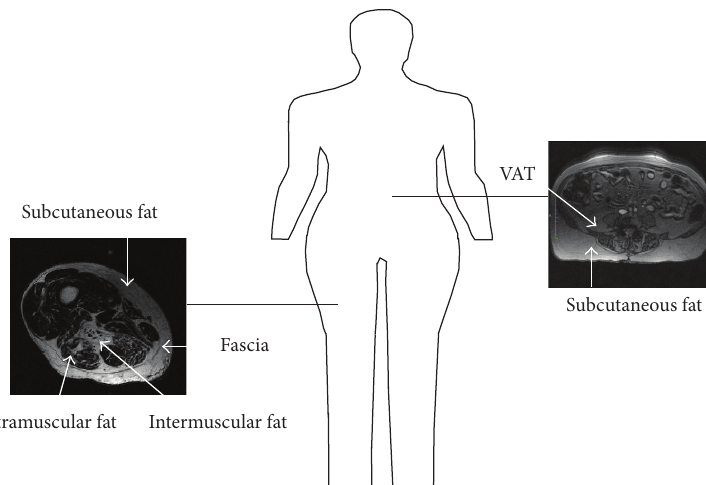
Figure 1: Intermuscular fat is generally considered to be any fat (including the fat between muscle groups and within a muscle) found beneath thefasciaofamuscleandisthewidestdefinitionforfatbeneaththefasciaofamuscle.Intramuscularfatisthevisiblefatfoundwithinamuscle. Intermuscular is considered to be an ectopic fat depot similar to visceral adipose tissue (VAT) found in the abdomen.